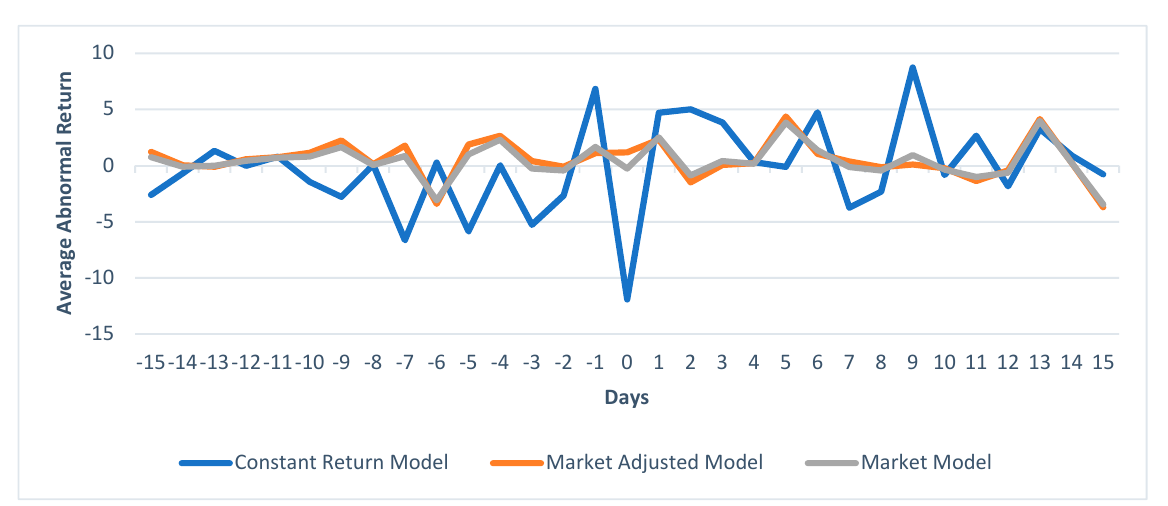
Figure 4. Event period AAR for the consumer goods sector (source: the authors).